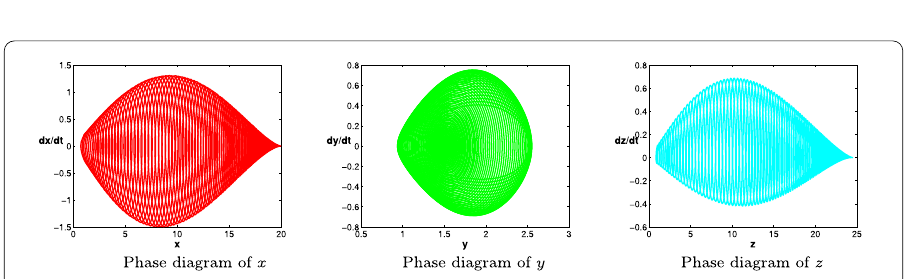
diagram of Experiment 1 with the value of the parameter is shown in Figs. 3–4. Figure